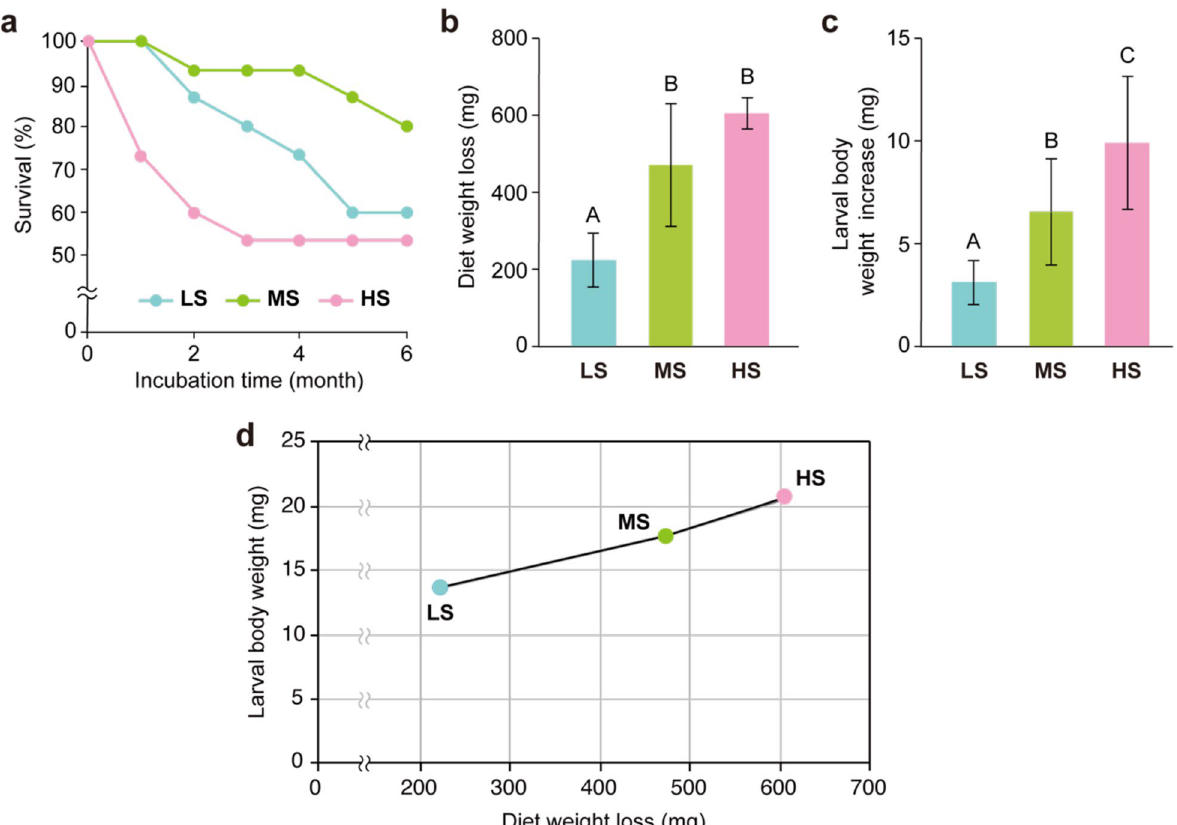
Fig. 2 Physiological characterizations of N. hirtum larvae fed with artificial diets. Survival rate ( a ) during the feeding period, and diet weight loss ( b ), larvae body weight increase ( c ) and the relationship between diet weight loss and larval body weight ( d ) after 6 months of feeding period are shown. Value refers to mean standard deviation. Different letters (A, B, and C) indicate significant differences among the diet treatments ± (Tukey HSD test; p < 0.05). Individual diet weight and larval body weight data are listed in Additional file 1: Table S1. LS, low-starch content diet. MS, medium-starch content diet. HS, high-starch content